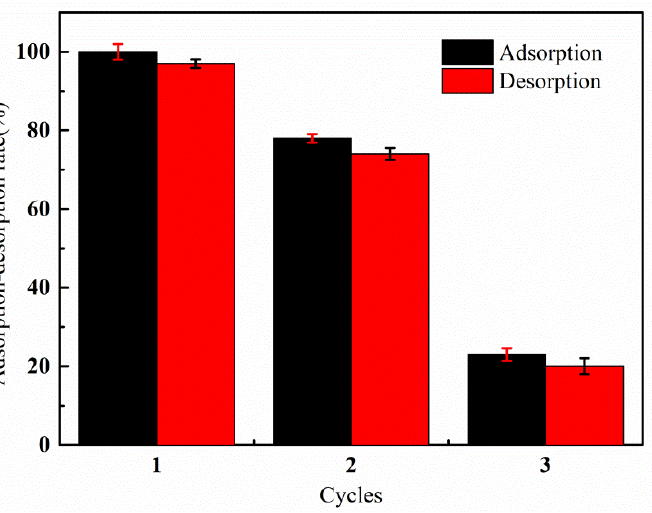
Figure 13. Adsorption–desorption rate in 1 mol·L − 1 NaOH solution under different cycles.